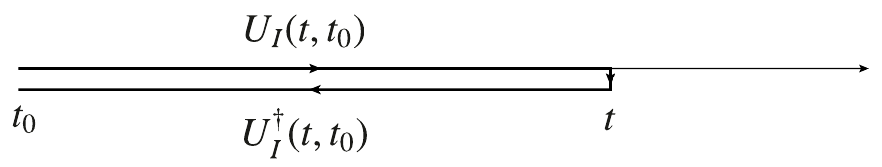
Figure 1 . The Schwinger-Keldysh